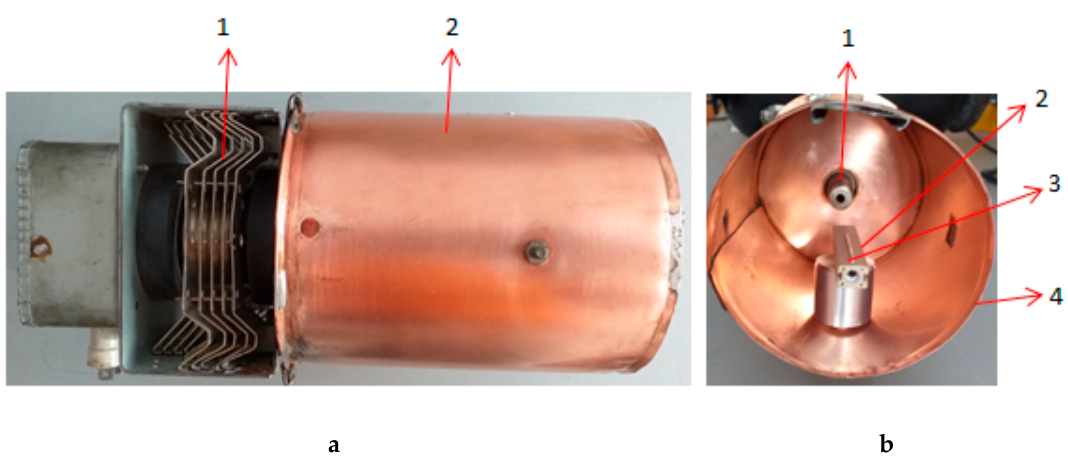
Figure 2. The microwave plasma generator: ( a ) 1—magnetron, 2—cylindrical cavity lateral view; ( b ) 1—magnetron antenna, 2—ceramic support, 3—metallic wire; 4—cylindrical cavity front view; ( a ) Lateral view ( b ) Front view.